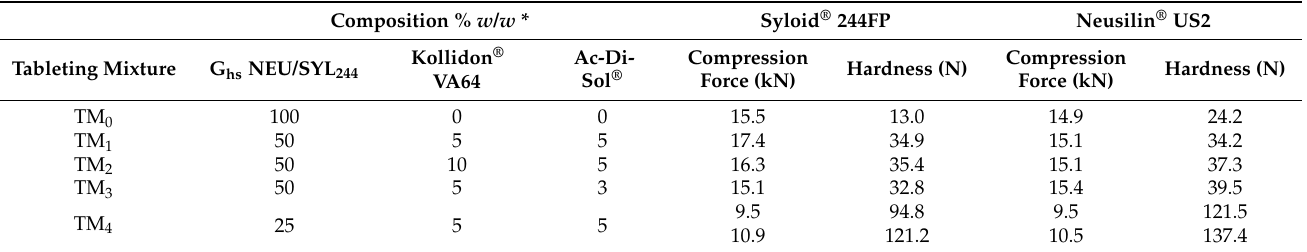
Table 4. Composition of tableting mixtures during formulation development, with the addition of compression force used and achieved tablet hardness for both most promising carrier